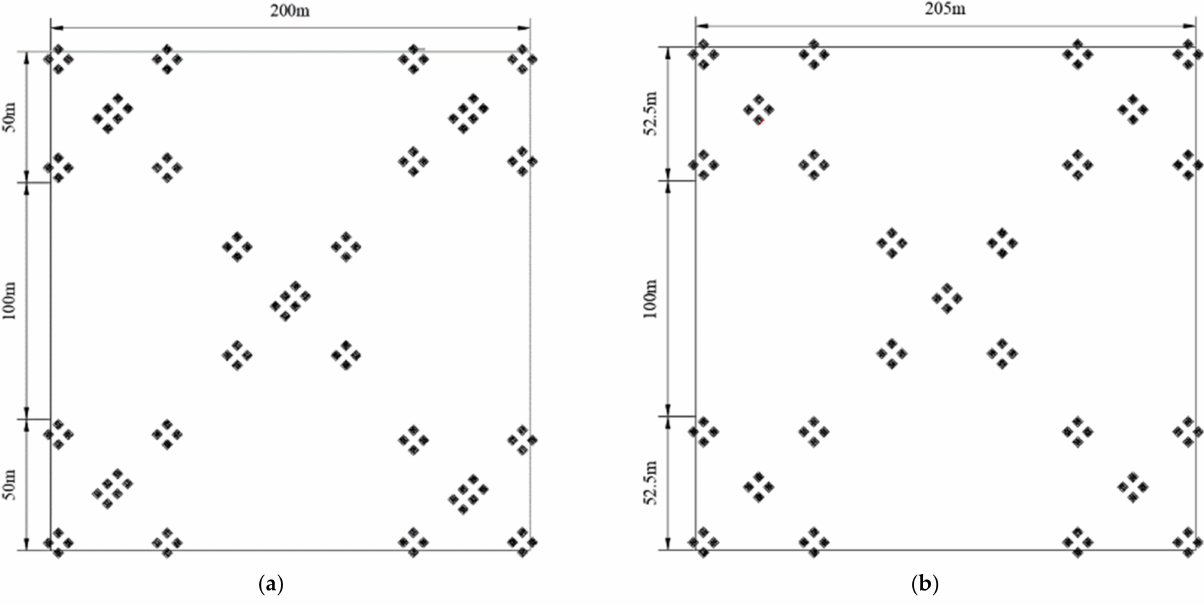
Figure 13. Comparison of M-shaped reef cluster before and after the adjustment. ( a ) Original design spacing; ( b ) adjusted spacing. Table 5. Comparison of M-shaped reef layout before and after